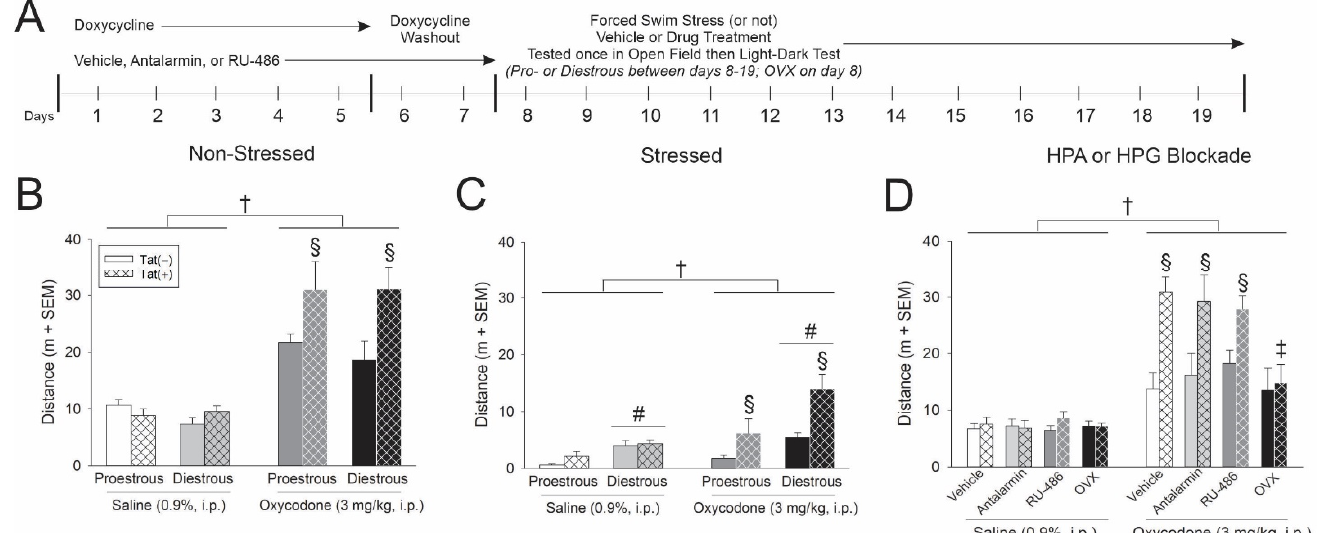
Figure 1. ( A ) HIV-1 Tat-transgenic, female mice [hatched bars; Tat(+)] or control counterparts [open bars; Tat(−) controls] had transgene expression induced via doxycycline (30 mg/kg, i.p., once daily for 5 days with 2 days for washout; n = 8–10/group). Some mice were pretreated with either vehicle. antalarmin, RU-486 or were ovariectomized (OVX). On the day of testing, proestrous, diestrous, or OVX mice were exposed to a forced swim stress (or not) and administered saline or oxycodone 15 min prior to assessment in an open field and light-dark transition test. ( B ) Distance (m) travelled in an open field among ( B ) non-stressed mice, ( C ) stressed mice and ( D ) mice that were pretreated with antalarmin or RU-486 or were OVX. † indicates a main effect for oxycodone-administered mice to differ from saline-administered controls. § indicates an interaction wherein oxycodone-administered Tat(+) mice differ from respective Tat(−) controls and saline-administered controls. # indicates a main effect of estrous cycle wherein diestrous mice differ from proestrous mice. ‡ indicates an interaction wherein oxycodone-administered Tat(+) OVX mice differ from all other oxycodone- administered Tat(+) groups, p <